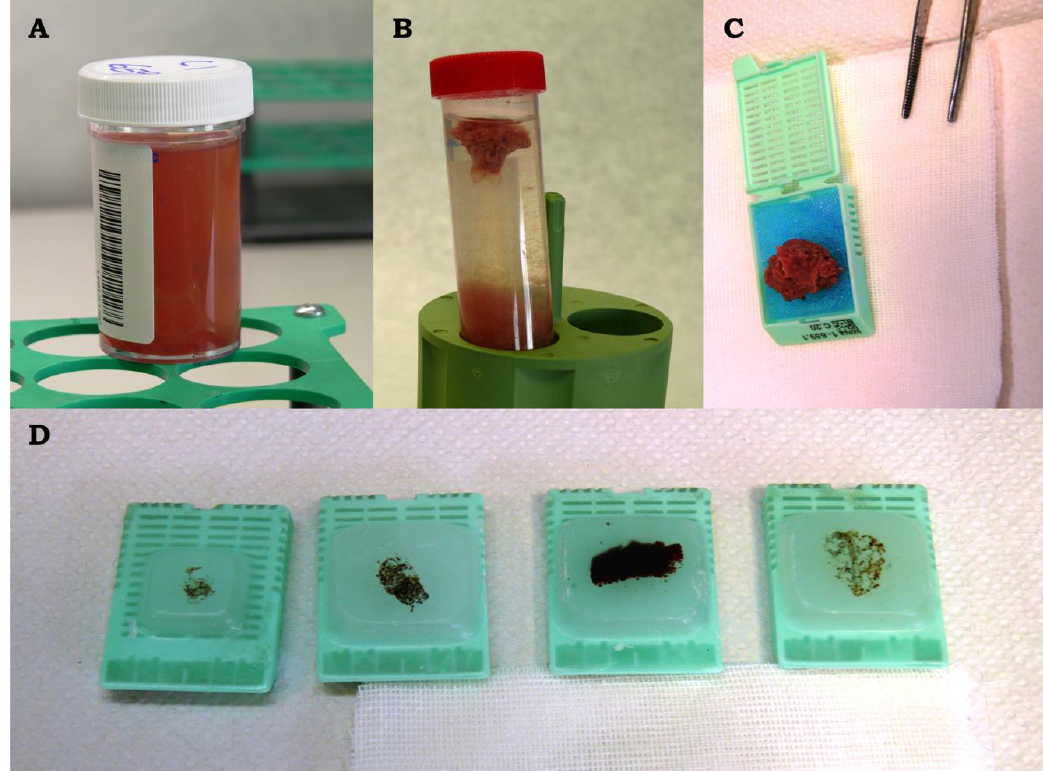
Figure 3. Cytological specimens into container with 10% neutral buffered formalin solution ( A ); solid clot ( B ) into cell for processing ( C ) and embedded in paraffin ( D ; 4 samples).